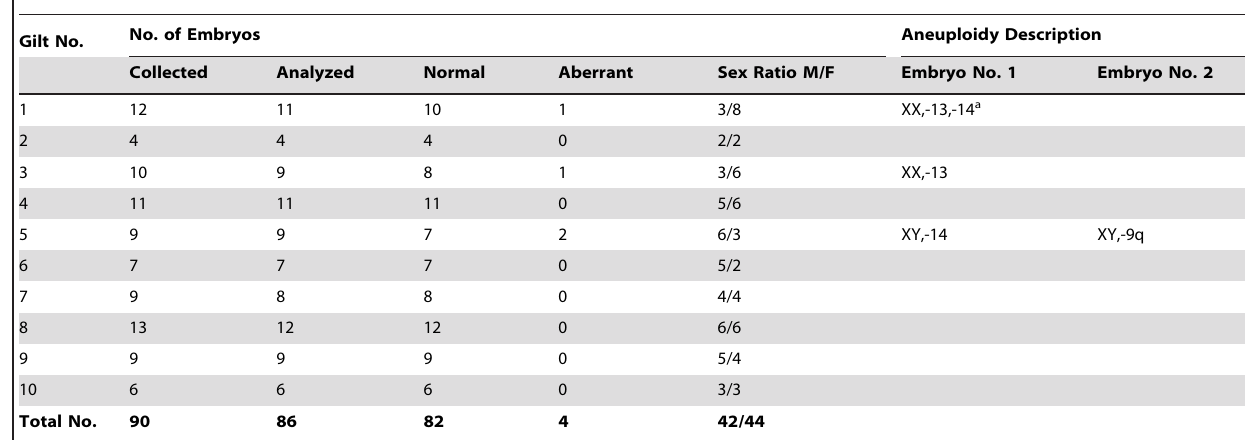
Table 2. The incidence and description of aneuploidies in pig embryos detected by CGH.